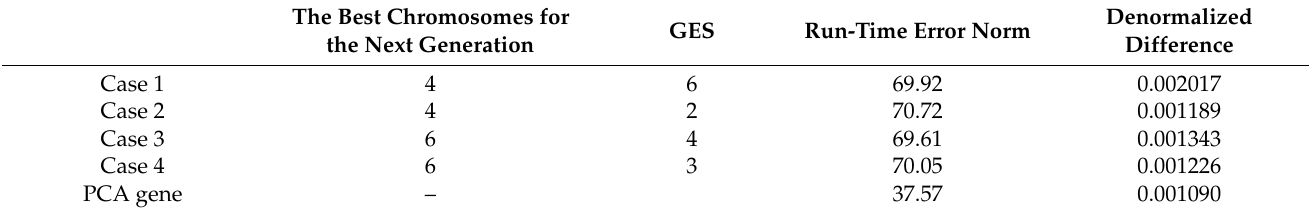
Table 5. The RNN training result under GA “back-to-original” optimizer. The Best Chromosomes